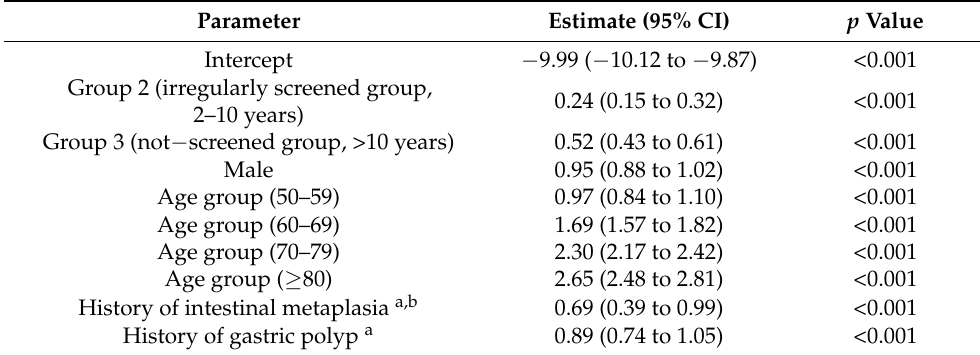
Table 4. Parameter estimates and 95% confidence intervals from multivariable logistic regression analysis estimating the probability of having interval gastric cancer after screening